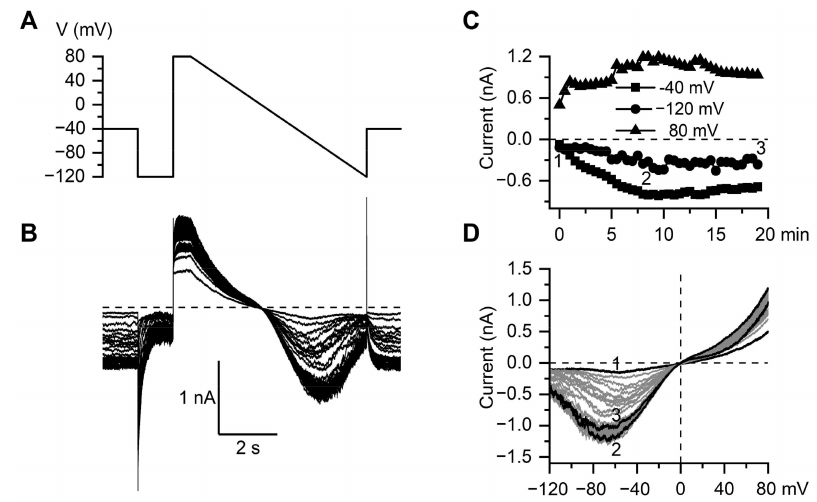
Figure 6. Characterization of GTP γ S-induced mI CAT in mouse ileal myocytes. ( A ) Voltage protocol and ( B ) corresponding representative superimposed linear leak-corrected current traces of the cationic current activated by GTP γ S infusion. ( C ) Time course of GTP γ S-induced mI CAT development at the three different test potentials ( − 40, − 120 and 80 mV) as indicated by different symbols. These represent mean current amplitudes at the holding potential of − 40 mV and during the last 200 ms of voltage steps to − 120 and 80 mV. ( D ) Corresponding superimposed current-voltage relations of mI CAT measured by the slow (6 s duration) voltage ramp from 80 to − 120 mV ( A ). Shown in black are three I-V curves measured immediately after membrane break-through ( A ), at the peak response to GTP γ S ( B ) and at the end of the experiment ( C ), as indicated by the same letters in panel ( C ).